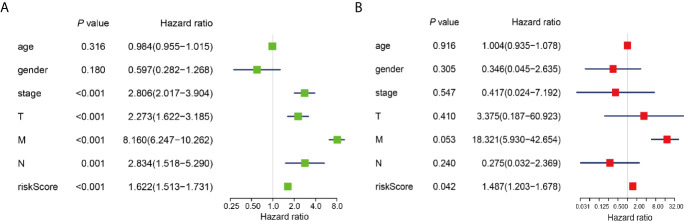
Identification of the independent prognostic factors in the PRCC cohort. (A) Single-factor analysis of clinicopathological parameter and risk score. (B) Multivariate analysis of clinicopathological parameters and risk score.